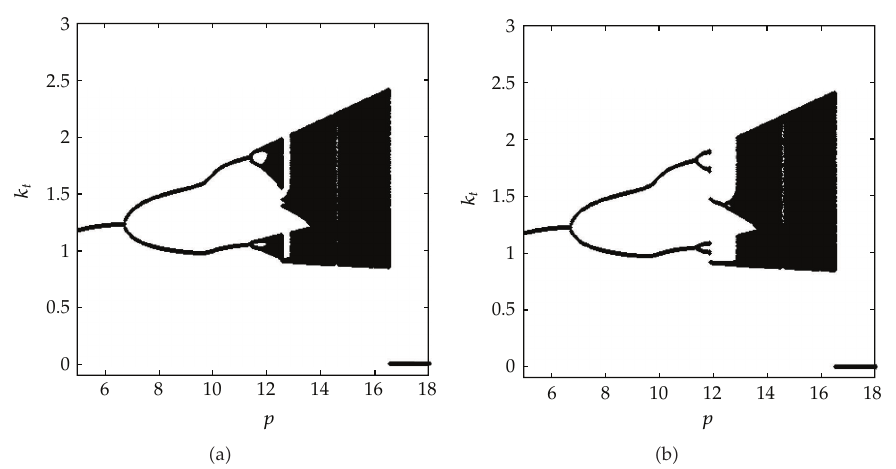
Figure 5: One dimensional bifurcation diagram of map F w.r.t. p for s r (cid:7) 0 . 7. (cid:3) a (cid:6) k 0 (cid:7) k M and the attractor A M is presented; (cid:3) b (cid:6) k 0 (cid:7) k m and the attractor A m is presented.